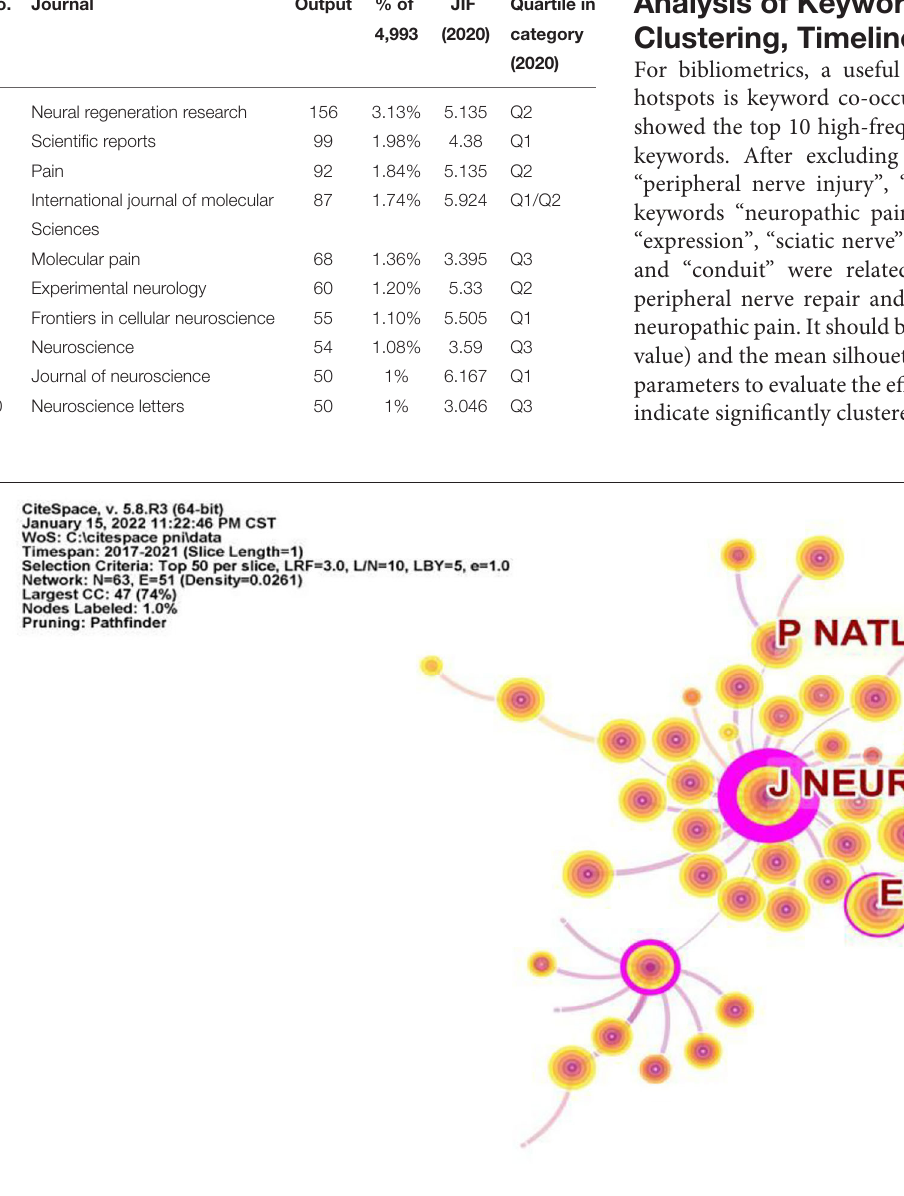
Frontiers in Neurology |